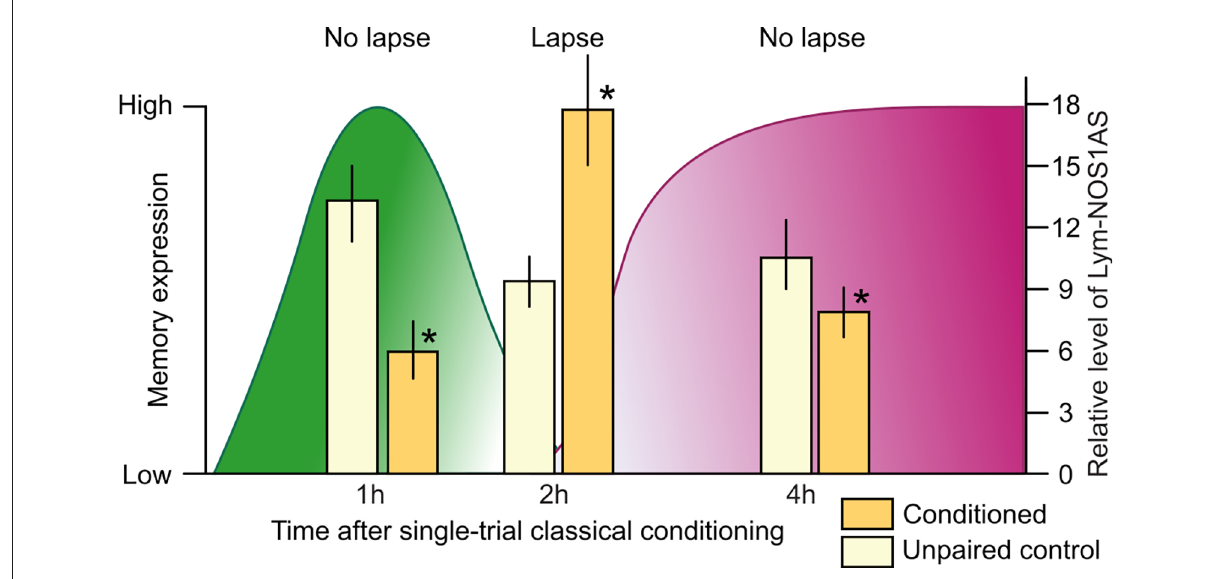
FIGURE2 Correlation between memory lapse/non-lapse periods and the level of Lym-NOS1AS expression after single-trial classical food-reward conditioning in Lymnaea . The levels of memory expression are indicated on the left axis, based on data from Marra et al. (2013). The levels of Lym-NOS1AS expression are indicated on the right axis, based on data from Korneev et al. (2021). Lym-NOS1AS expression levels are significantly lower at the 1 h and 4 h non-lapse time points in the cerebral ganglia from the trained group of animals (yellow bars) compared to controls (white bars). By contrast, at the 2 h lapse time point, Lym-NOS1AS expression level is significantly higher in the cerebral ganglia of trained vs. control animals. Asterisks indicate significant differences ( p < 0.05) between the conditioned and unpaired data at the same time point ( n = 20 animals per group, unpaired two-tailed t -tests with Welch’s